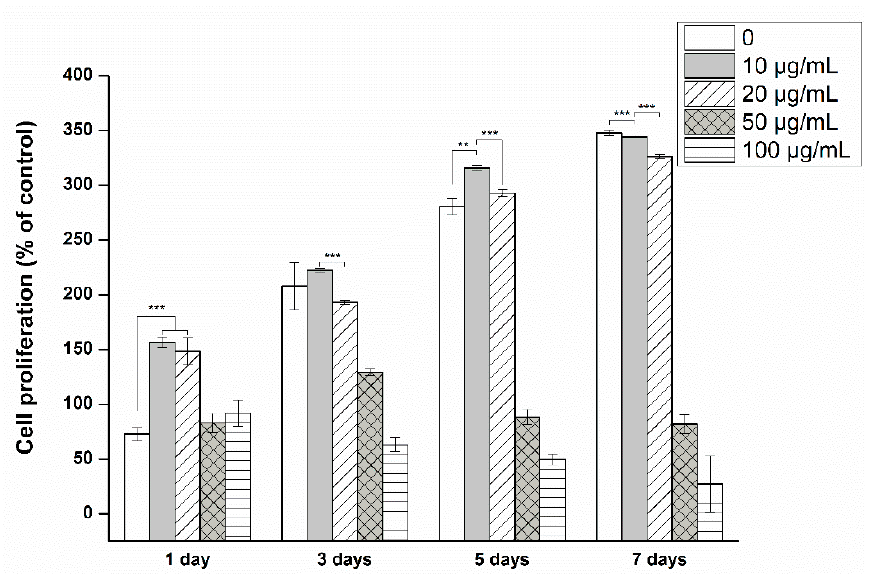
Figure 2. Cell proliferation at different MXene concentrations (** p < 0.01 and *** p < 0.001).